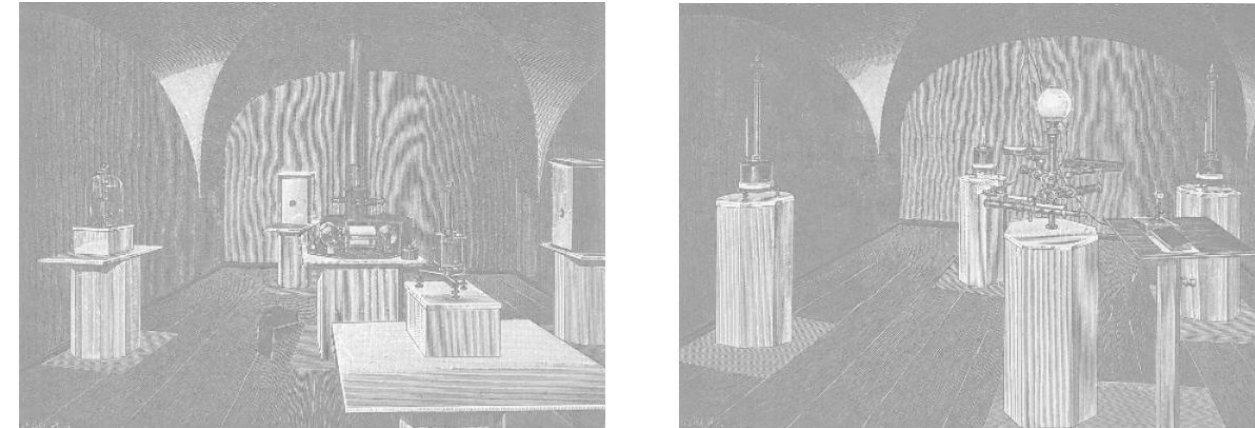
Figure 10. Main recording system (left) and backup variometer system for manual reading (right). Source: Eschenhagen (1894).